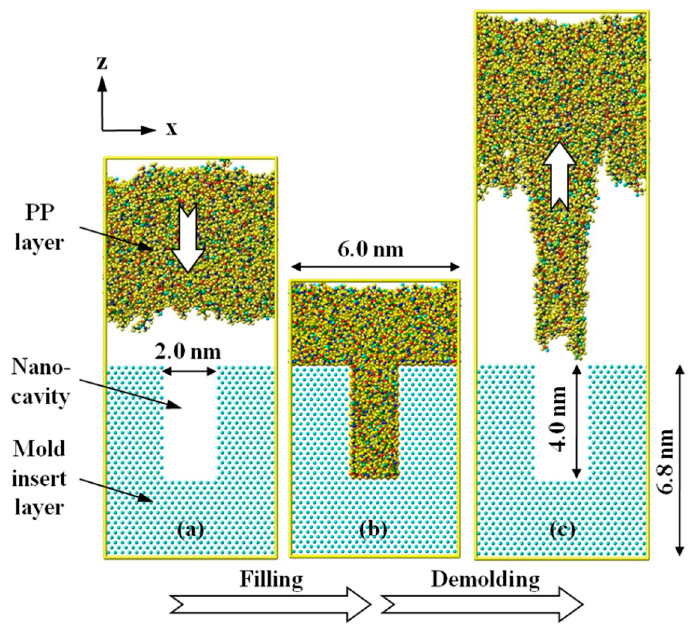
Figure 1. Atomistic model and procedure for the simulation. ( a ) The PP molecules fill the nano-cavity via injection molding, forming the nanostructure after cooling process in order to build ( b ) the initial model for demolding simulation. Afterwards, ( c ) the nanostructure is gradually pulled out from the mold